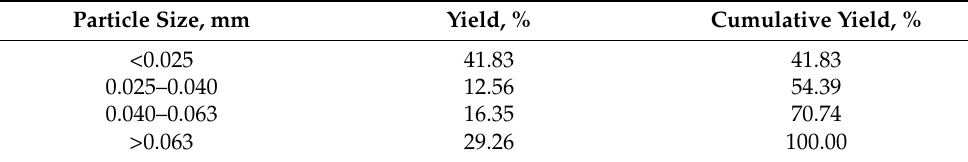
Table 1. Particle size distribution of waste sample from Pilawa